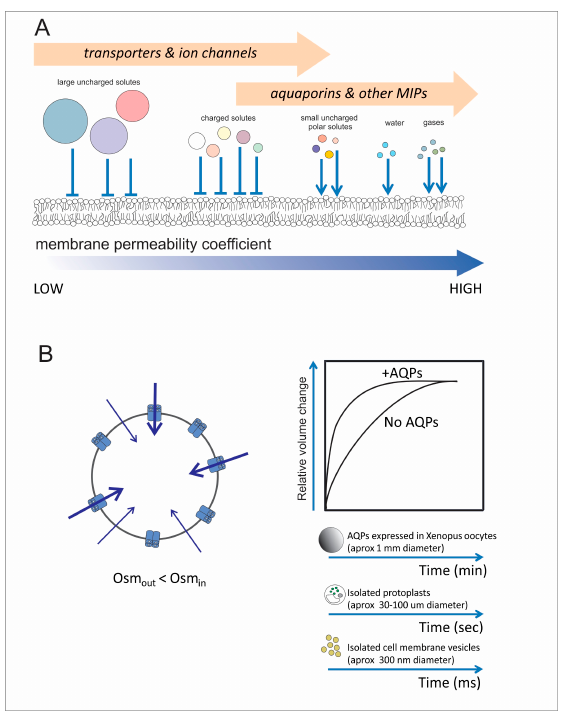
Figure 1. Biological membranes and aquaporins. ( A ) Biological membranes are selectively permeable. Large solutes and polar ones (e.g., ions) have very low permeability coefficients and request specific protein transporters to facilitate their transfer. On the other hand, small uncharged polar solutes as well as water and gases have less resistance to permeate through the phospholipid bilayer and protein transporters are optional. However, now we know specific channels (aquaporins) are crucial molecular entities for controlling/regulating the rate of exchange of water, gases and certain solutes including ions in certain cases. In the scheme, the arrows represent the capacity to increase the membrane permeability by introducing integral membrane proteins into the phospholipid bilayer. We propose there is an overlap in the type of transporters that can be responsible for regulating the permeation pathway of a specific solute/water/gas. ( B ) Water exchange is facilitated when AQPs that are water channels are present. As the phospholipid bilayer is also permeable to water, osmotic swelling is possible under an imposed osmotic gradient even in the absence of aquaporins. However, their presence allows a faster swelling response. In the cartoon it is represented the water entry and the consequent cell swelling imposed by the osmotic gradient. Different techniques are available to measure water membrane permeability in isolated cells or smaller